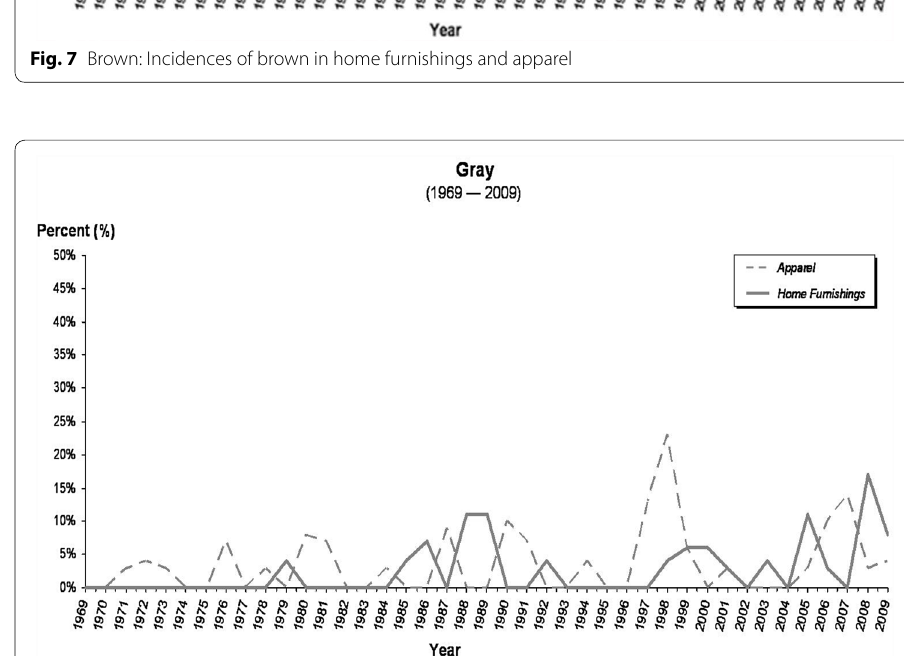
Fig. 8 Gray: incidences of gray in home furnishings and